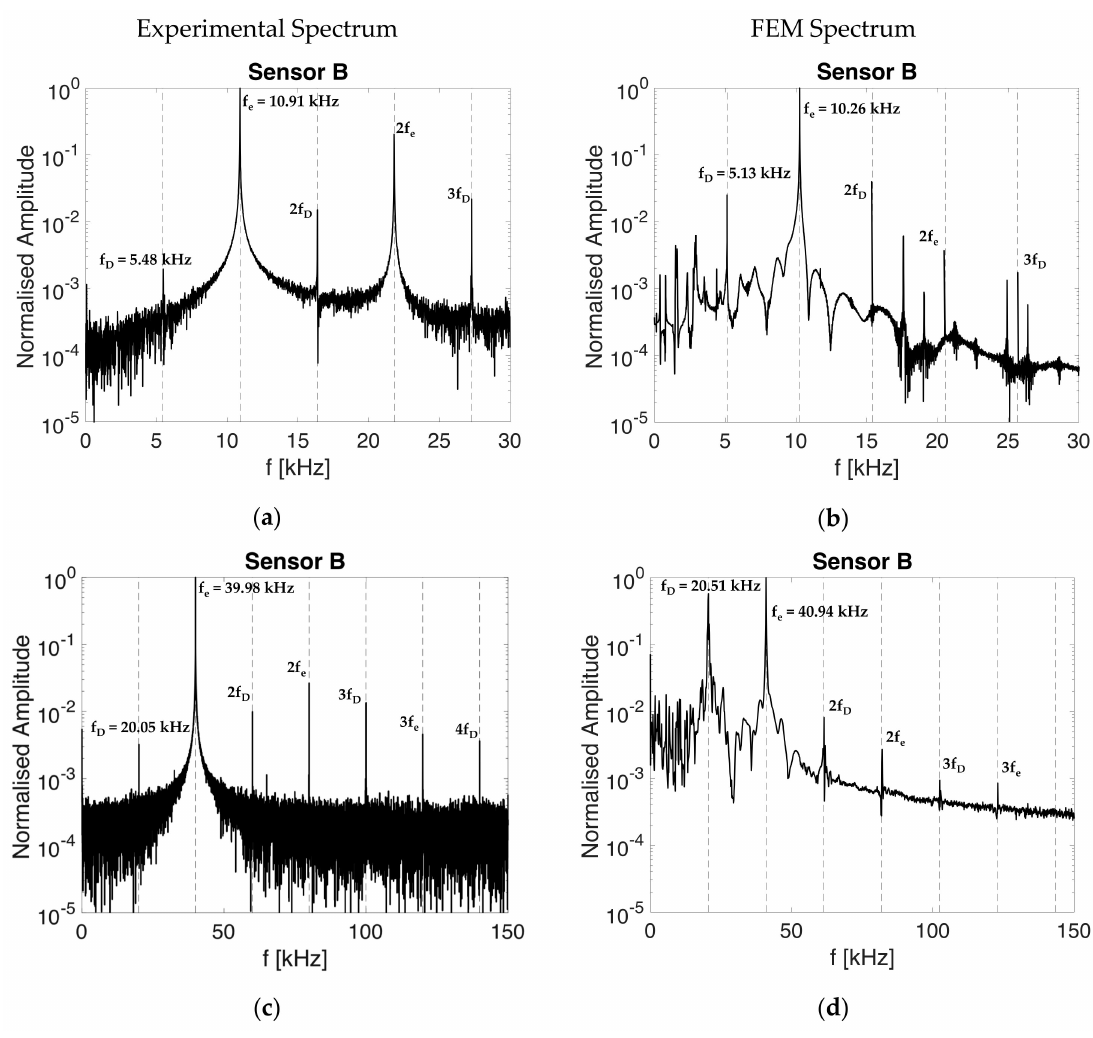
Figure 7. Experimental ( f e = 10.91 kHz in ( a ) and f e = 39.98 kHz in ( c )) and FEM ( f e = 10.26 kHz in ( b ) and f e = 40.94 kHz in ( d )) spectra for subharmonic detection at sensor